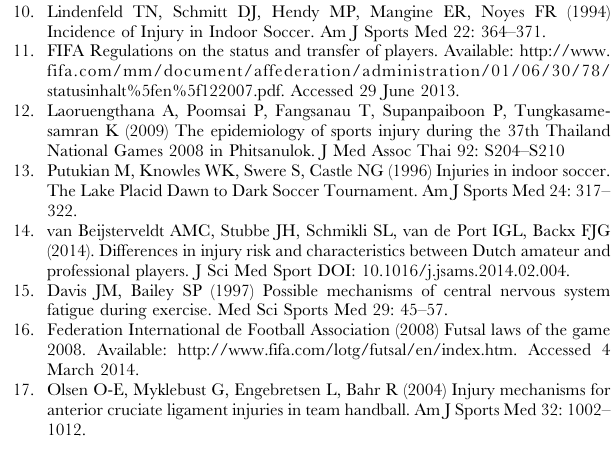
Figure S1 Injury report form used in the present